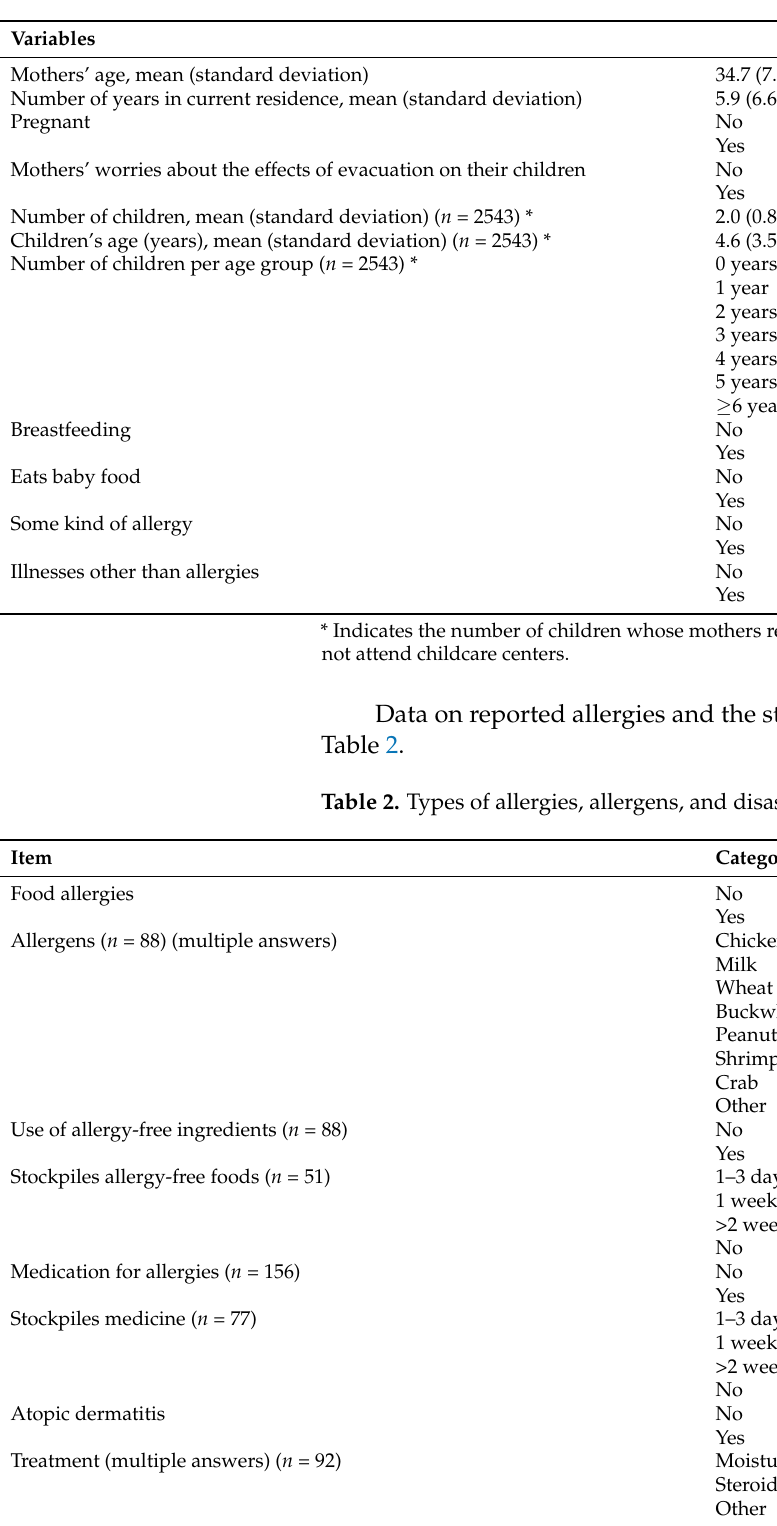
Table 1. Demographic characteristics of participants ( n = 1298).